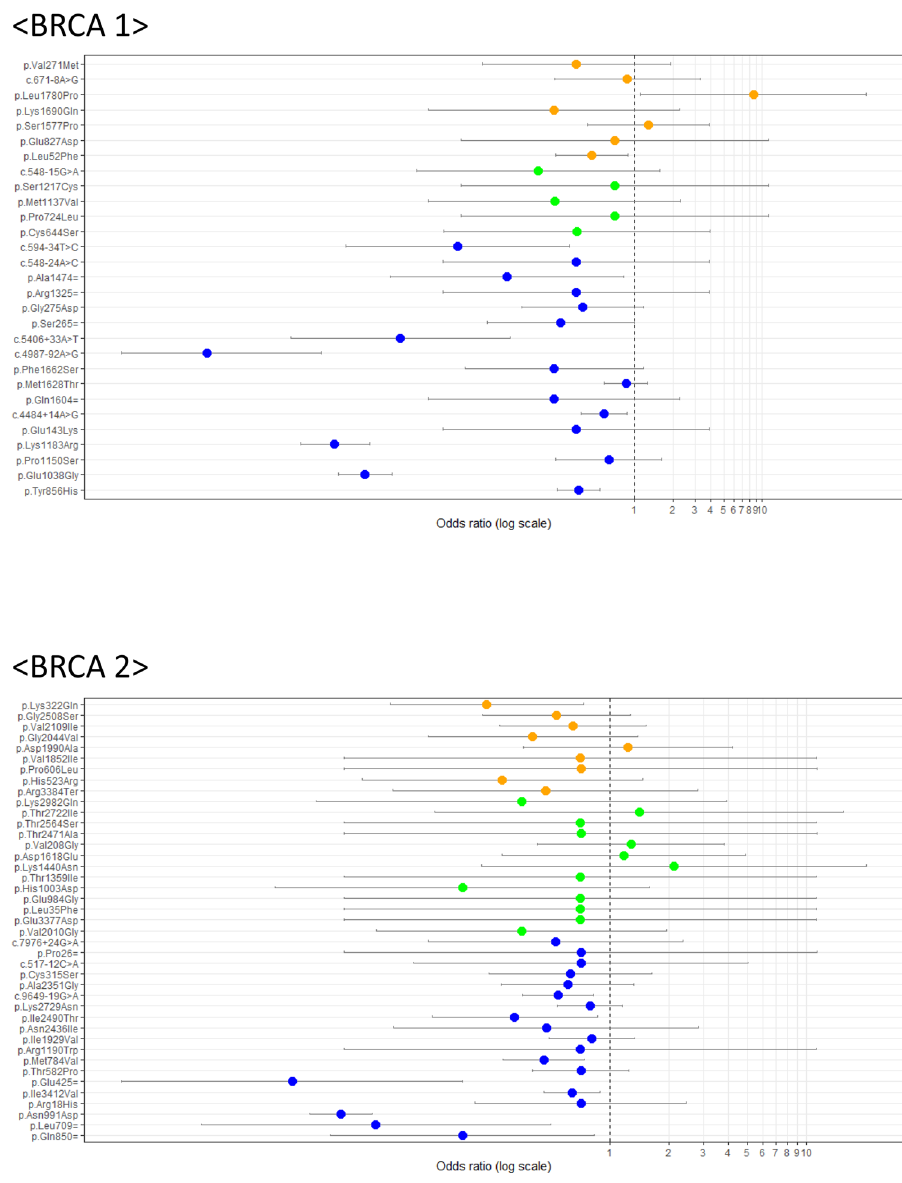
Figure 2. Odds ratios (ORs) using Korean population data from the Korean Reference Genome Database (KRGDB). Variants that could be identified in the KRGDB were classified according to the ClinVar database (vertical axis). Round dots indicate ORs, and the continuous line through each dot indicates a 95% confidence interval. Variants with orange, green, and blue dots indicate conflicting interpretations of pathogenicity, uncertain significance, and benign/likely benign variants according to the ClinVar database,